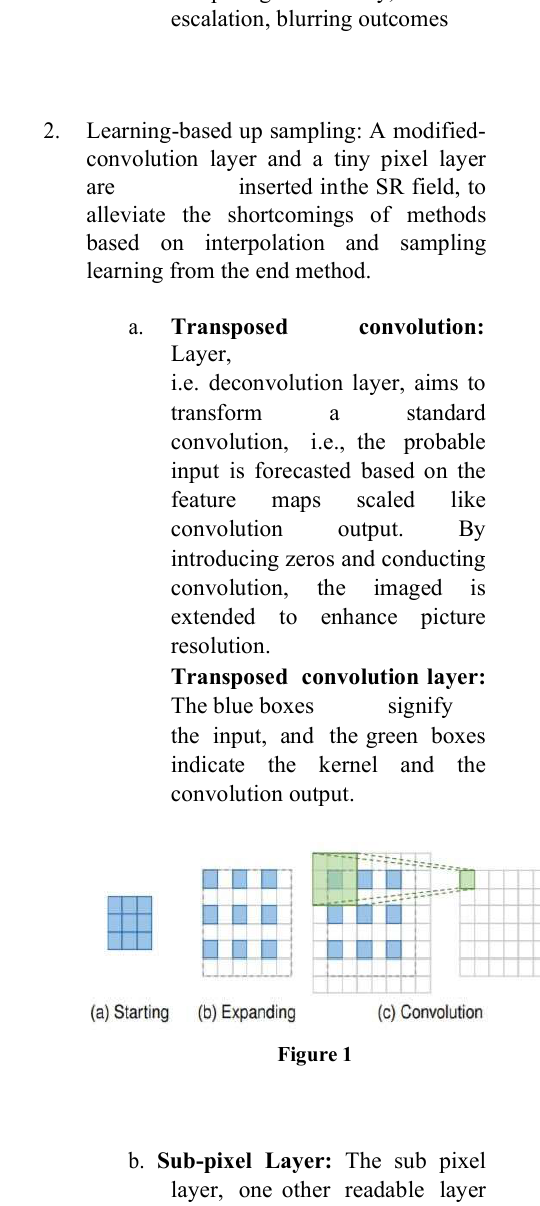
b. Sub-pixel Layer: The sub